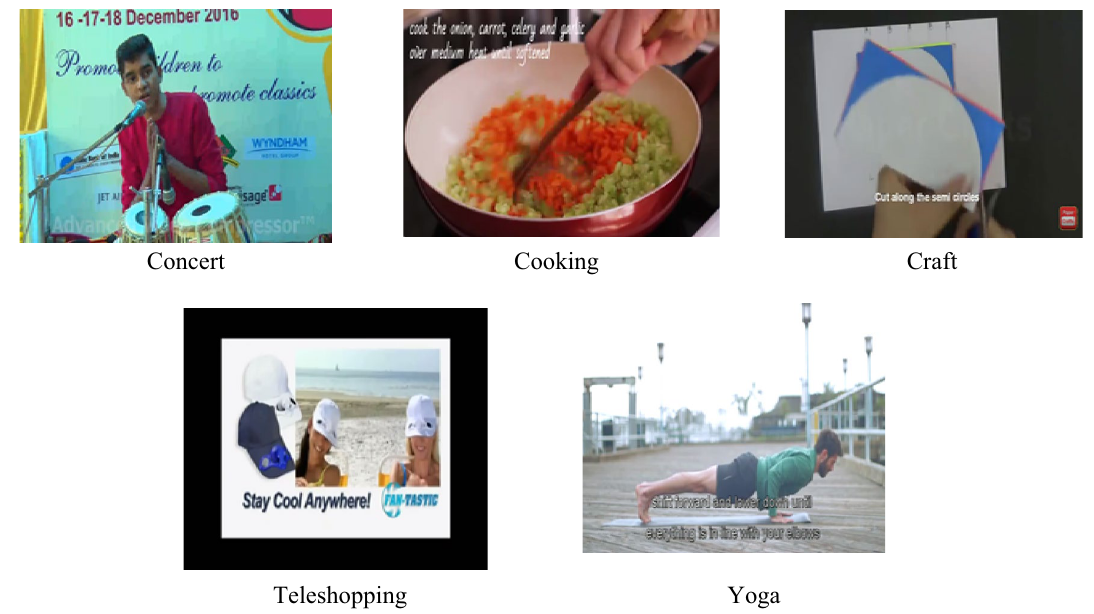
Fig. 1 Example of five action image classes (Original Source: